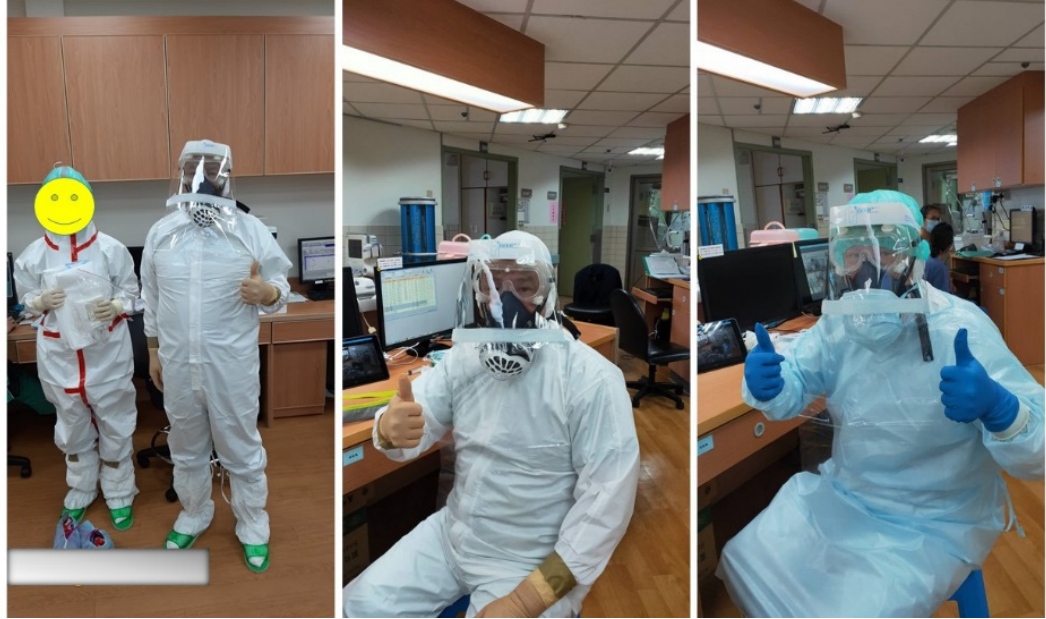
Figure 1. Examples of personal protective equipment (PPE) used by medical staff while caring for patients undergoing aerosol generating medical procedures (AGMP) during the COVID-19 pandemic.